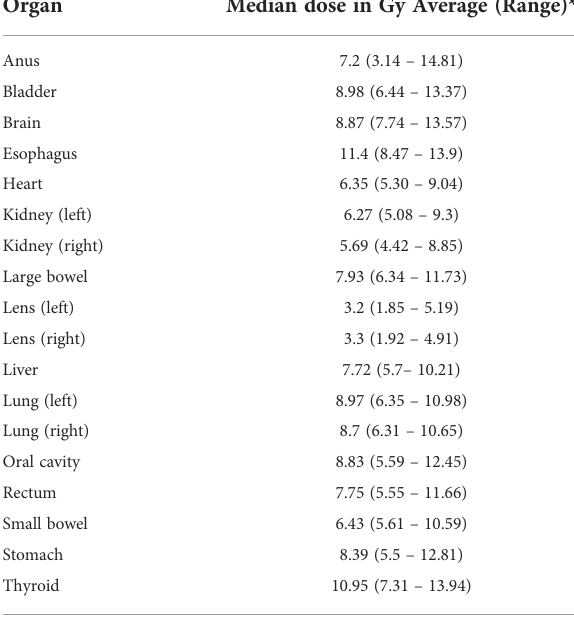
TABLE 2 Organs at risk (OARs) average and range of median